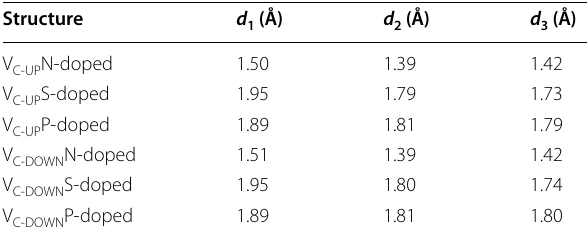
Table 2 Calculated bond lengths of C2 vacancy and N-, S-, P-doped PG Structure